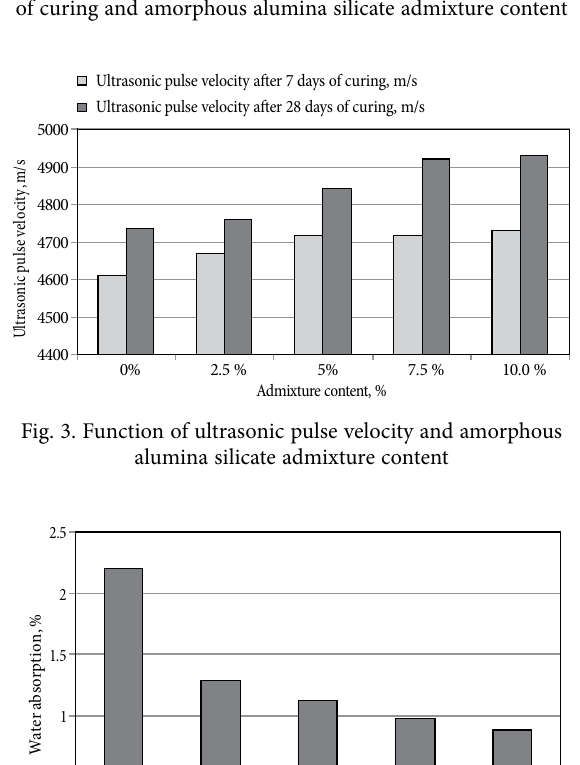
Fig. 2. Function of compressive strength after 7 and 28 days of curing and amorphous alumina silicate admixture content